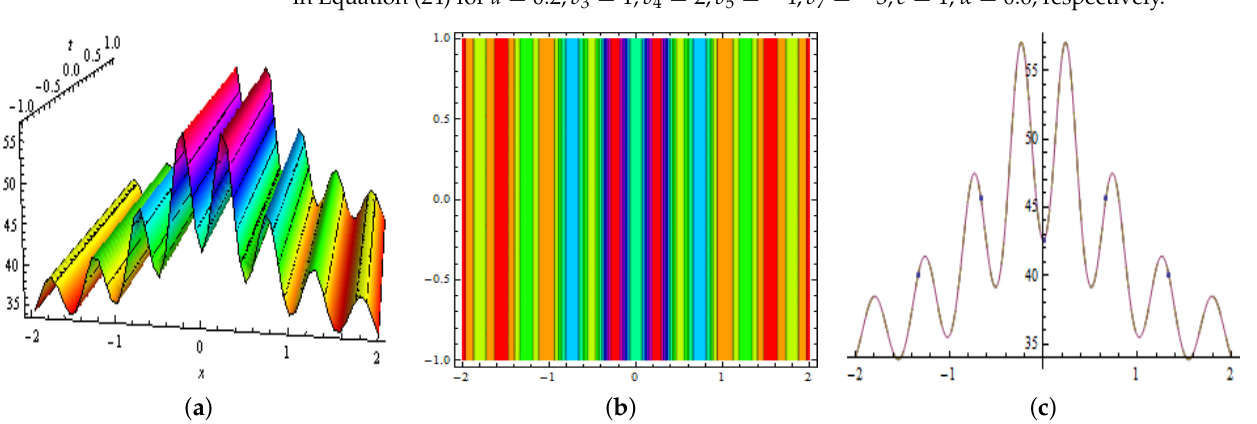
Figure 4. illustrated three-dimensions in ( a ); contour in ( b ) and two-dimensions in ( c ), Plots of n 32 ( x , t ) in Equation (24) for a = 0.2, b 3 = 1, b 4 = 5, b 5 = − 4, b 7 = − 3, c = 1, α = 0.8, respectively. Set II. For b 1 =